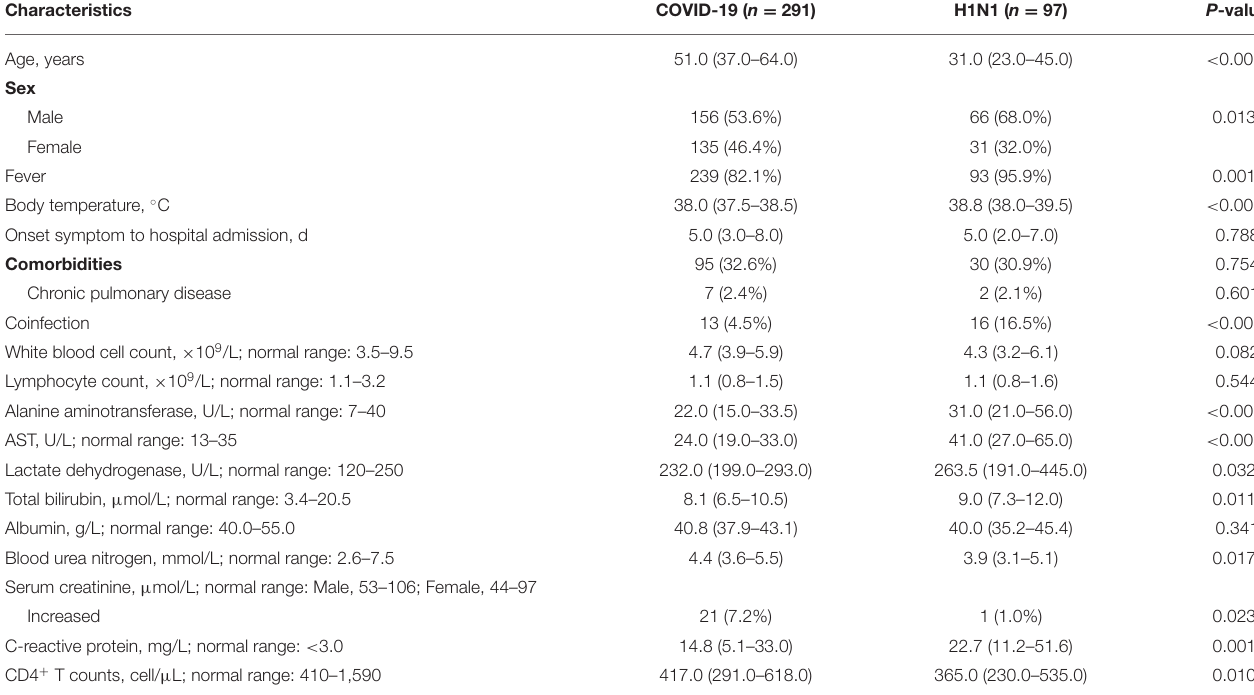
TABLE 1 | Baseline clinical and laboratory characteristics of the patients with COVID-19 pneumonia vs. those with H1N1 pneumonia. Characteristics